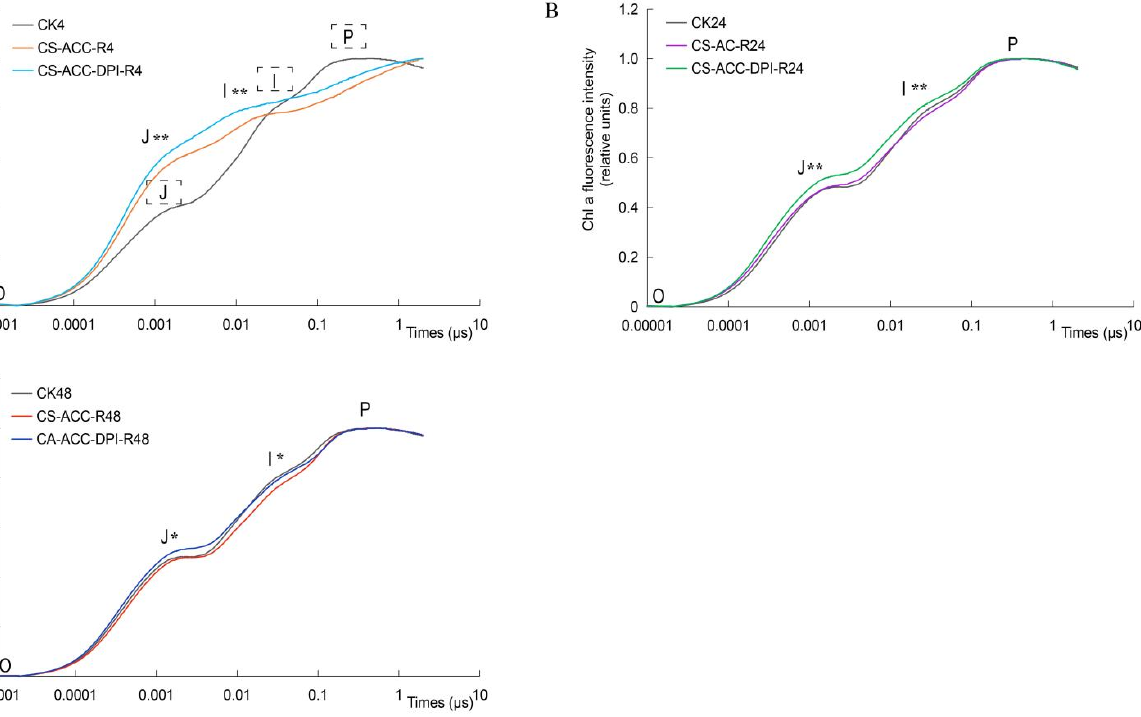
Figure 5. RBOH -dependent signaling affected the photosynthetic efficiency of PSII during recovery after CS-ACC in cucumber seedlings. ( A – C ): the changes in the Chl a fluorescence induction curve during 4 ( A ), 24 ( B ), and 48 h ( C ) of recovery, respectively, after CK, CS-ACC, and CS-ACC-DPI treatment, respectively. CK: the control, cucumber seedlings with no acclimation and at 25 °C during recovery; CS-ACC: cucumber seedlings were treated with a cold stress regime of 10 °C for 1 h, 25 °C for 1.5 h, and 1 °C for 3 h; CS-ACC-DPI: DPI was sprayed onto the seedlings during recovery after CS-ACC. CS-ACC: cold stress acclimation; R: recovery, 25 °C. Point O: initial fluorescence intensity when the PSII reaction center was completely open; Point J: fluorescence intensity when electron receptors Q A were in an initial instantaneous maximum reduction state, which reflects the reduction rate of Q A ; Point I: the size of the reduced plastiquinone (PQ) library; Point P: fluorescence intensity of all electron receptors in PSII that are in the maximum reduced state. Different colored lines represent different treatments. Significant differences for A and C are indicated for the Tukey HSD test (3 treatments; p < 0.05; n ≥ 4). Significant differences for B are indicated for Student’s t test (2 treatments; p < 0.05; n ≥ 4). “*” represents the 0.05 level, and “**” represents the 0.01 level.